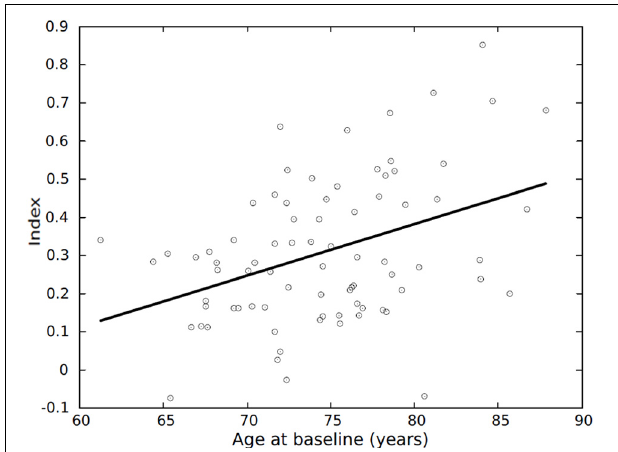
FIGURE 3 | Average index vs. age, for the 79 CTL individuals part of the longitudinal dataset. Average index = (index at baseline + index at 1-year)/2. CTL, healthy control.